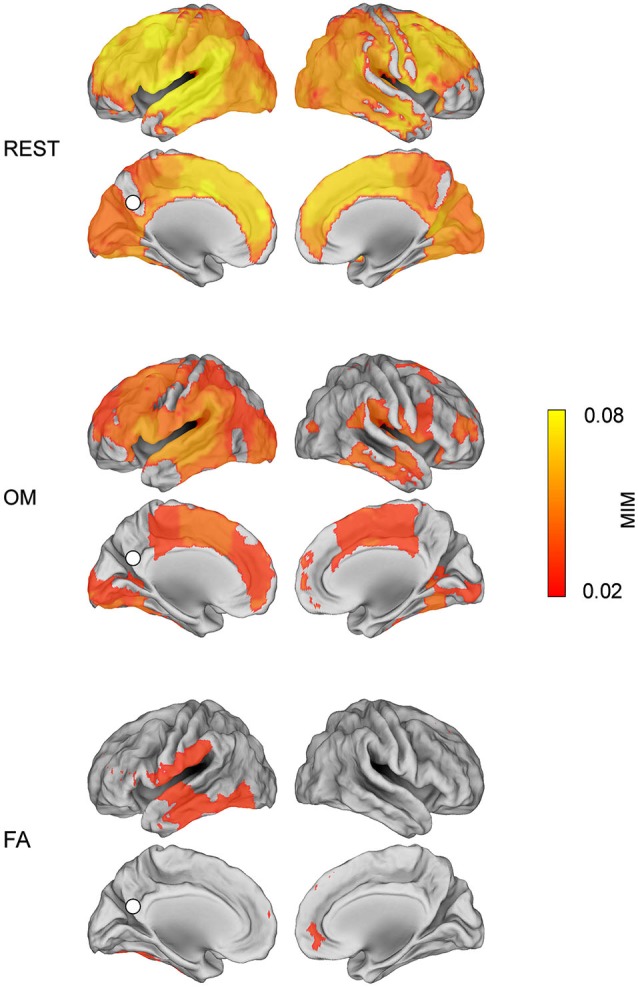
Alpha band MIM connectivity map (p < 0.01, Bonferroni corrected value) with respect to the PCC seed in the three conditions: REST, OM meditation, FA meditation.